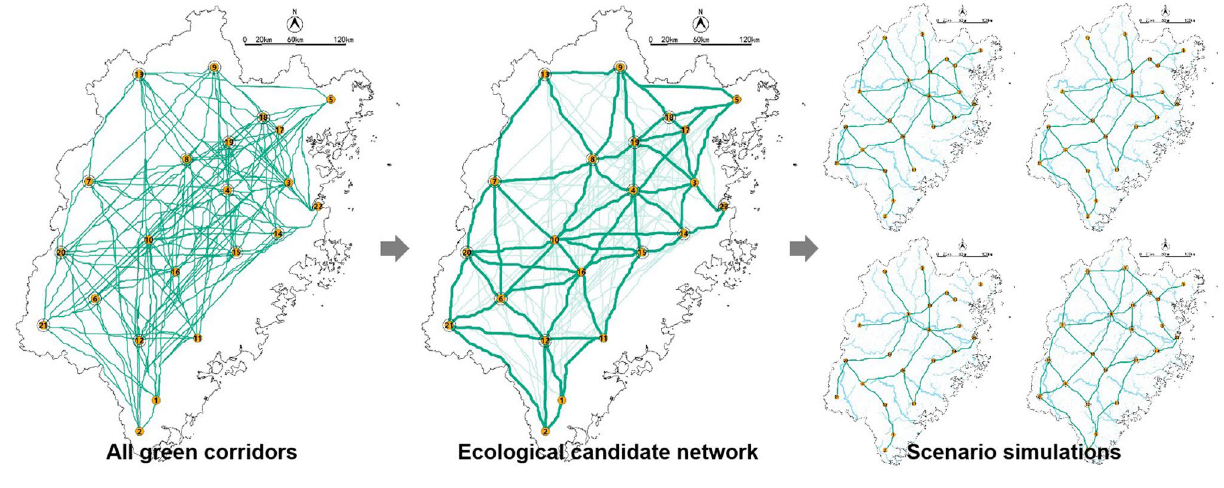
Figure 10. The process diagram of scenario simulations.